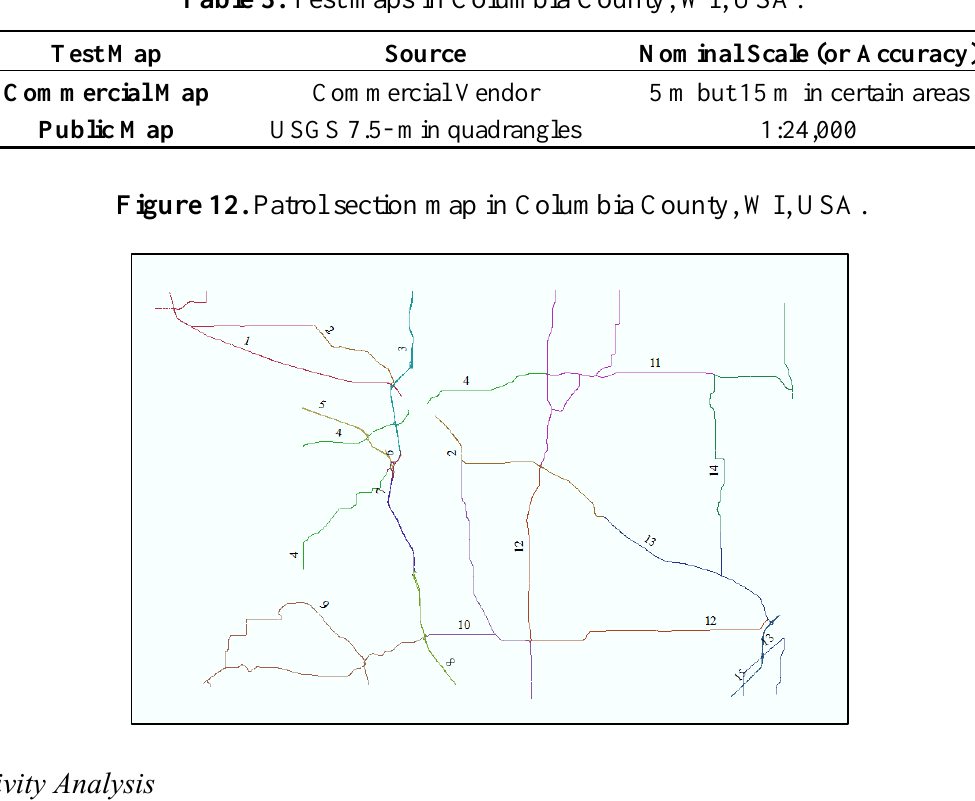
Table 3. Test maps in Columbia County, WI, USA.